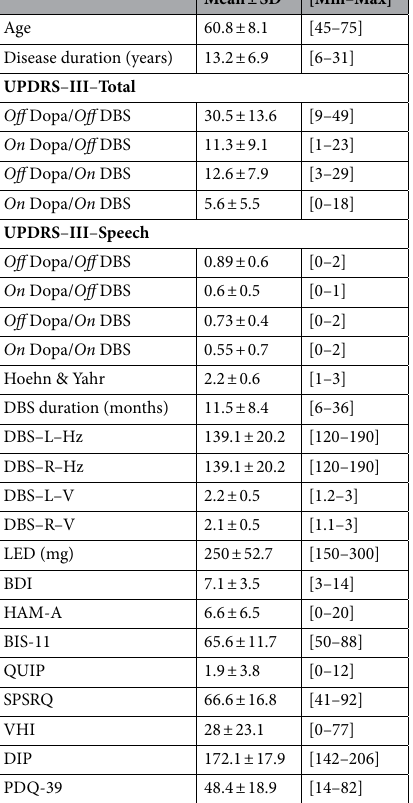
Table 1. Demographics, clinical data and STN-DBS parameters of the Parkinson’s disease patients. BDI: Beck Depression Inventory; BIS-11: Barratt Impulsiveness Scale; DIP: Dysarthria Impact Profile; HAM-A: Hamilton Anxiety Rating Scale; Hz: STN-DBS frequency in hertz; LED: levodopa equivalent dose during the experiment (Tomlinson et al., 2010); PDQ-39: Parkinson’s Disease Questionnaire–39; QUIP: Questionnaire for Impulsive- Compulsive Disorders; SPSRQ: Sensitivity to Punishment and Sensitivity to Reward Questionnaire; UPDRS: Unified Parkinson’s Disease Rating Scale; V: STN-DBS voltage in volts; VHI: Voice Handicap